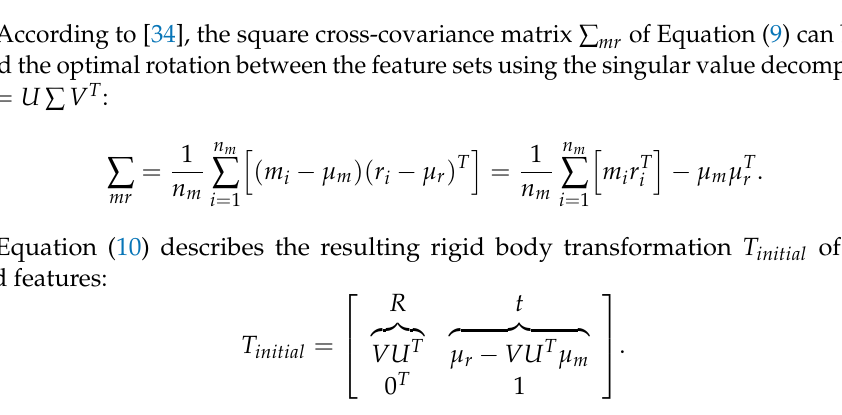
Figure 9. Workflow of the data registration after film-cooling hole segmentation. ( a ) Overview of the data registration approach. ( b ) Sequence of the RANSAC-based pose